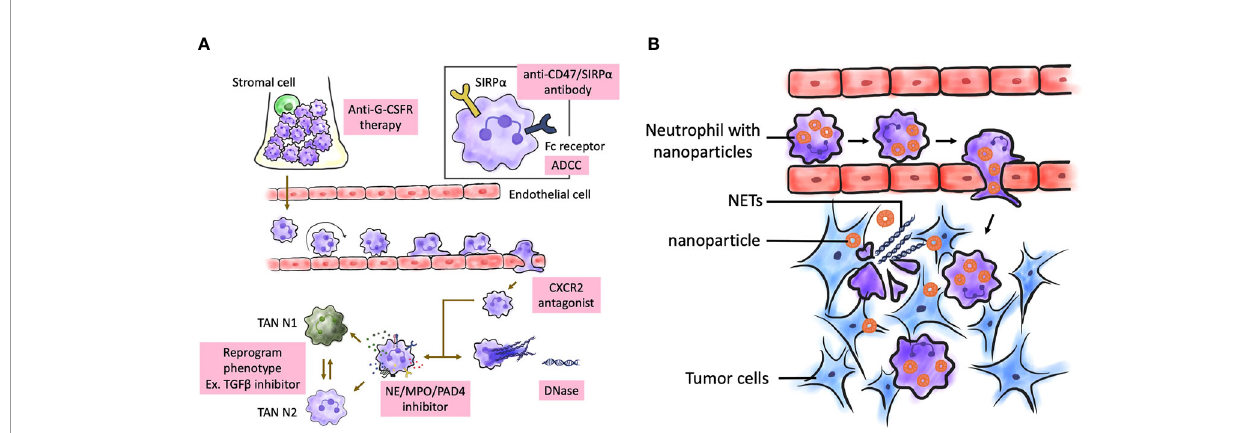
FIGURE 3 | Possible treatment targeting neutrophils in brain tumors. (A) Several aspects of neutrophil biological function may be therapeutically targeted from the maturation process to effector functions. The targeting aims are to enhance or inhibit neutrophil function, or to restore normal neutrophil function. Enhancement can be achieved by inhibiting signal-regulatory protein a (SIRP a ). Inhibitors of CXCR1, CXCR2 can be used to block neutrophil activation and migration. NE, MPO, and PAD4 inhibitors can be used inhibit NETosis. (B) Neutrophils can be nanocarrier to mediate anticancer nanoparticle drug delivery. After surgical resection of brain tumors, in fl ammatory signals were ampli fi ed at post-resection sites, which attracted neutrophils with nanoparticles to migrate into in fi ltrating brain tumors along the chemotactic gradient, and results in disruption of the neutrophils and release of NETs. That renders a concomitant release drug into tumor microenvironment and produce antitumor effect. NETs were also released on excessive activation by in fl ammatory cytokines. G-CSFR, G-CSF receptor; MPO, myeloperoxidase; NE, neutrophil elastase; NET, neutrophil extracellular trap; PAD4, peptidylarginine deiminase 4; TAN, tumor-associated